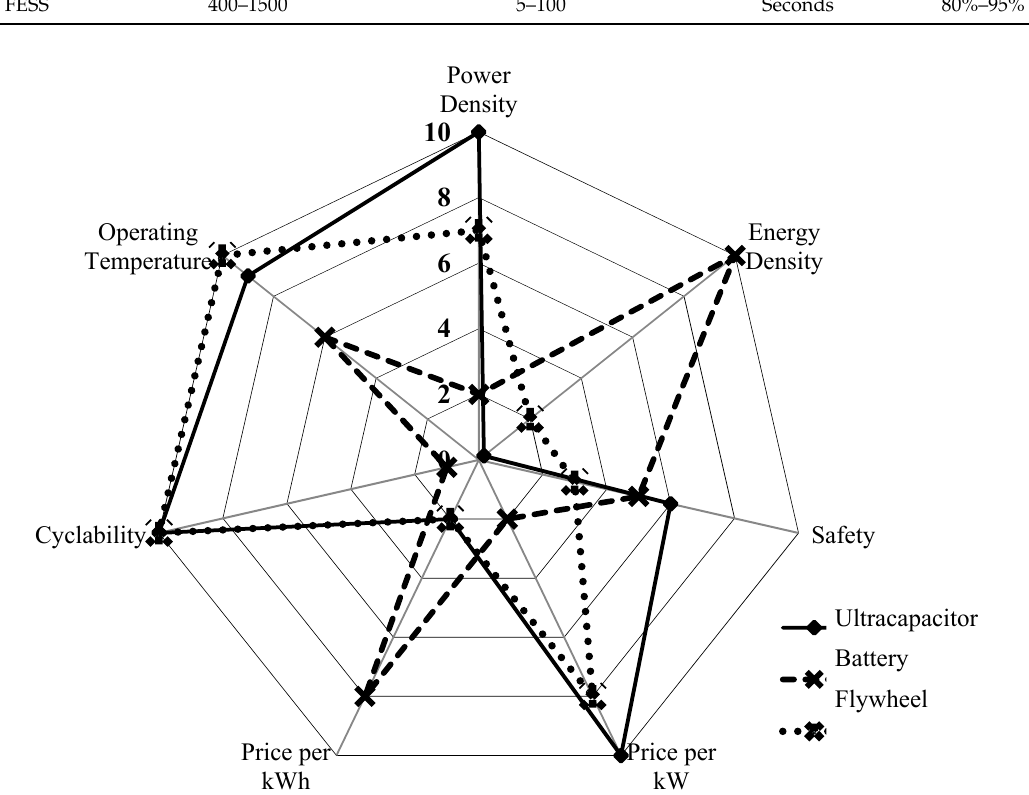
Figure 7. A qualitative comparison between an ultracapacitor, battery, and flywheel. Due to the fast power changes with the high peak value (in seconds) and independent DC link of each crane, UCs with high power density and fast response time are the best choice for peak power and cost savings. Today, UCs are used in a wide range of applications in industry and transportation